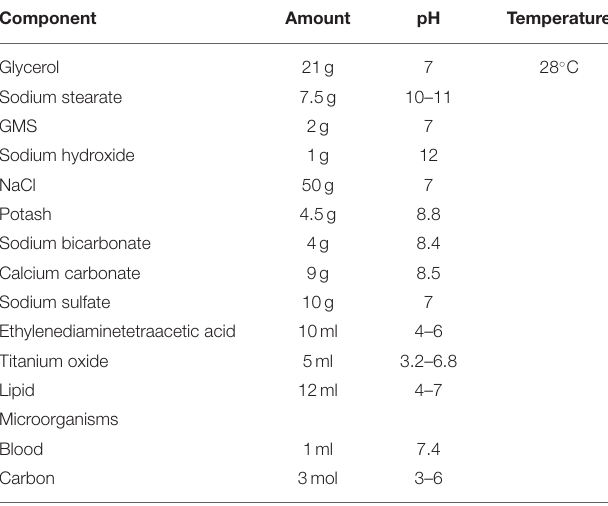
TABLE 2 | Residential building’s gray water nutrients type B-handwashing (with a special handwash